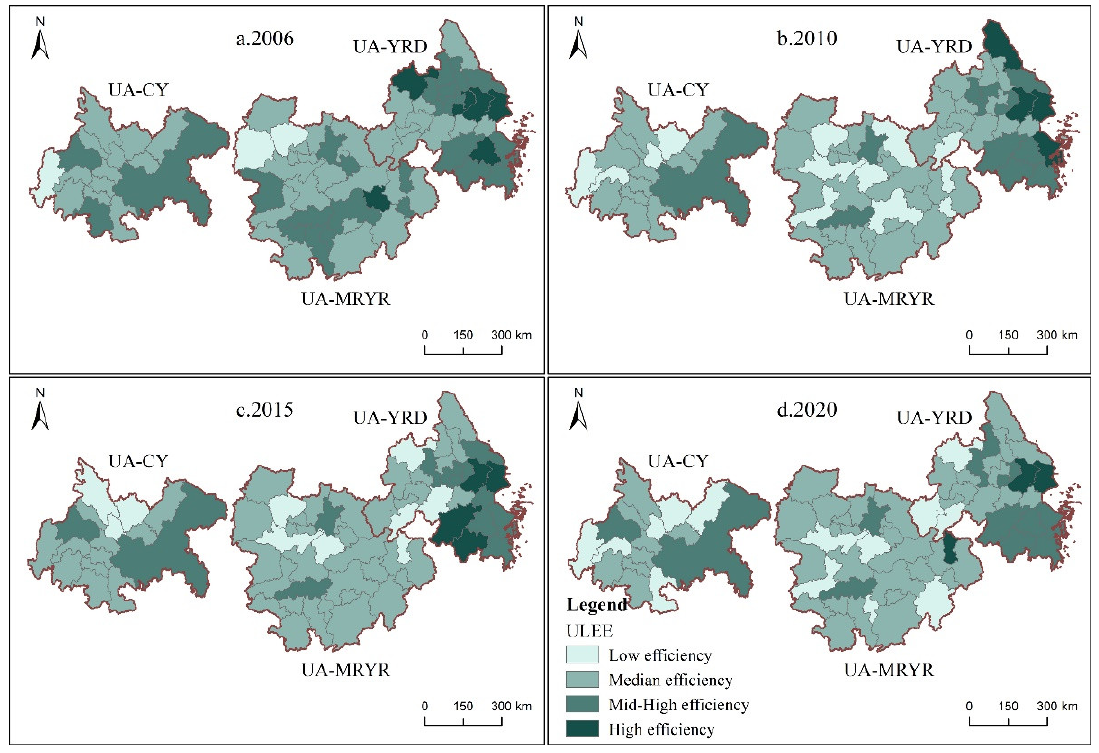
Figure 4. Spatial differences of ULEE among the three major urban agglomerations.